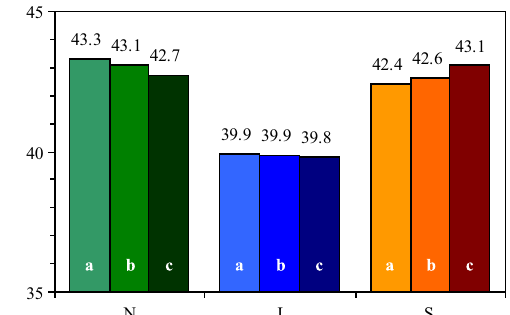
Fig. 5. Average rebound index readings corresponding to the testing